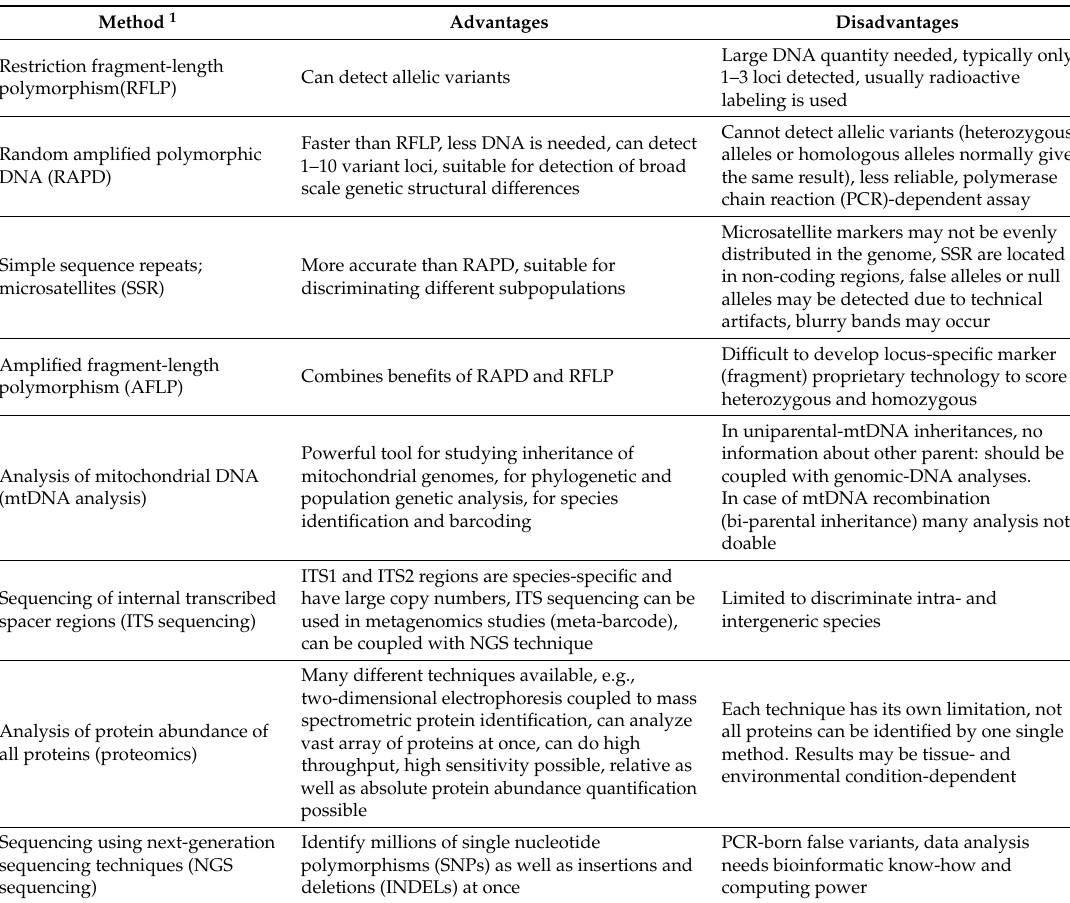
Table 1. Method-specific advantages and disadvantages of molecular methods typically used for comparison of host-specific fungal